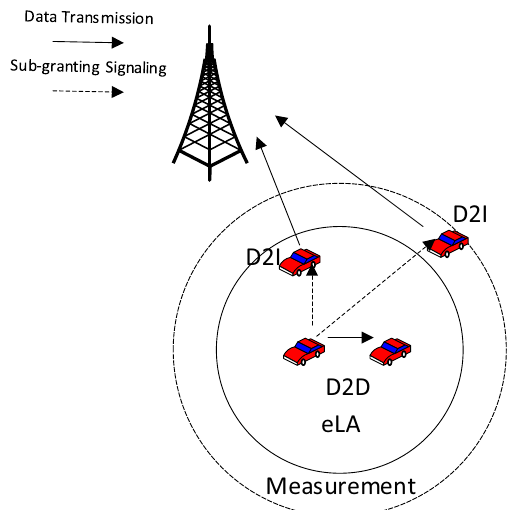
Fig. 11 An illustrative example of the sub‑grant provider coverage area for measurement‑based and eLA‑based approaches